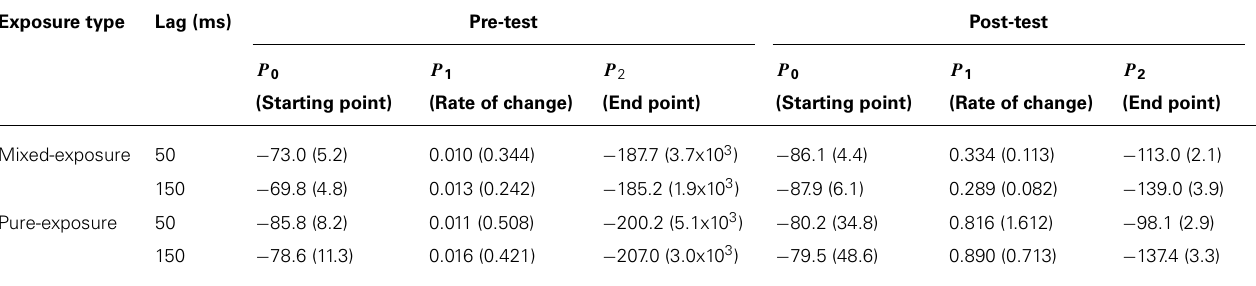
Table 3 | Estimated parameters in fitting a decay function for the mean tap asynchronies. Exposure